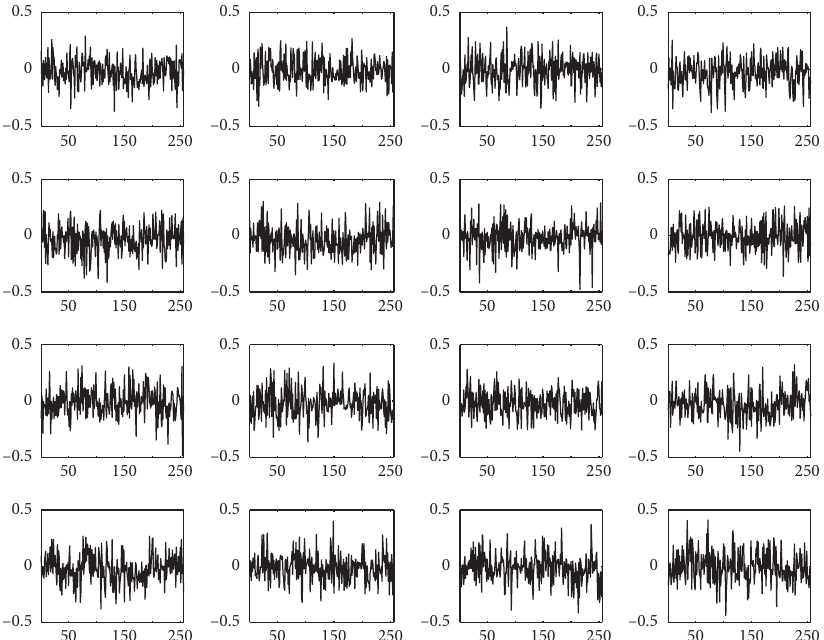
Figure 8: Part of the learned dictionary atoms by using the IKSVD method on the signal as shown in Figure 6(c).